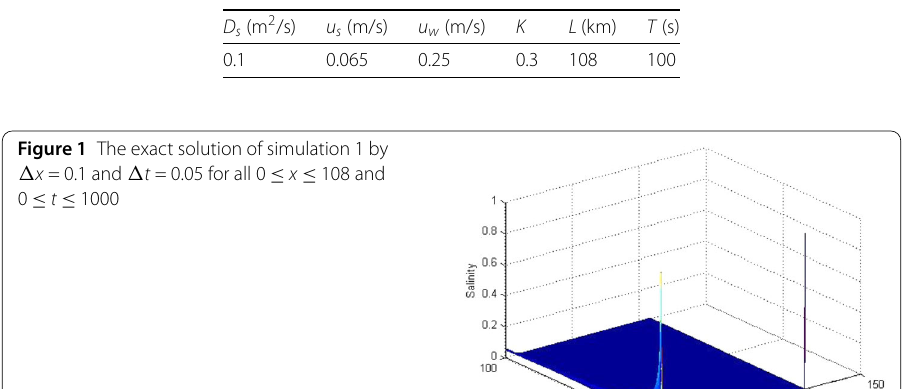
Figure 2 The FTCS solution of simulation 1 by (cid:4) x = 0.1 and (cid:4) t = 0.05 for all 0 ≤ x ≤ 108 and